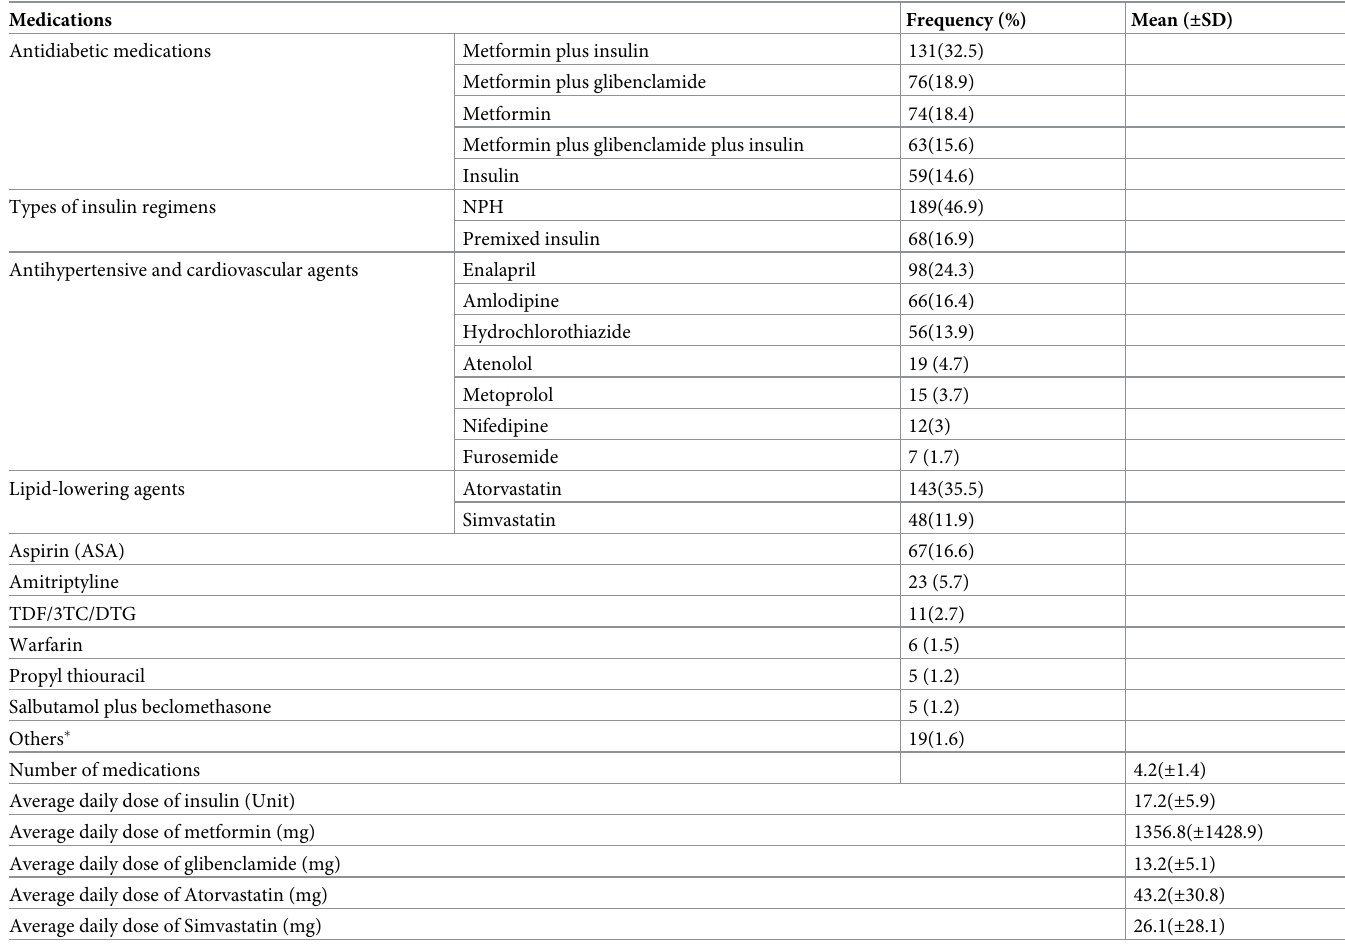
Table 2. Distribution of medications used to the treatment of T2DM patients with